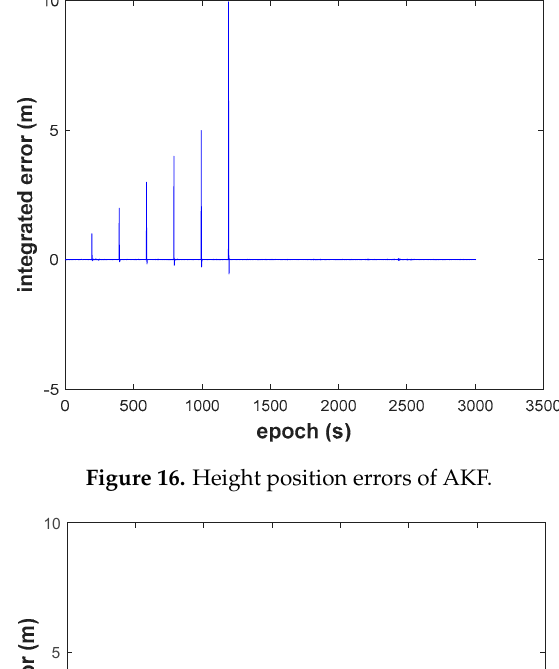
Figure 16. Height position errors of AKF.